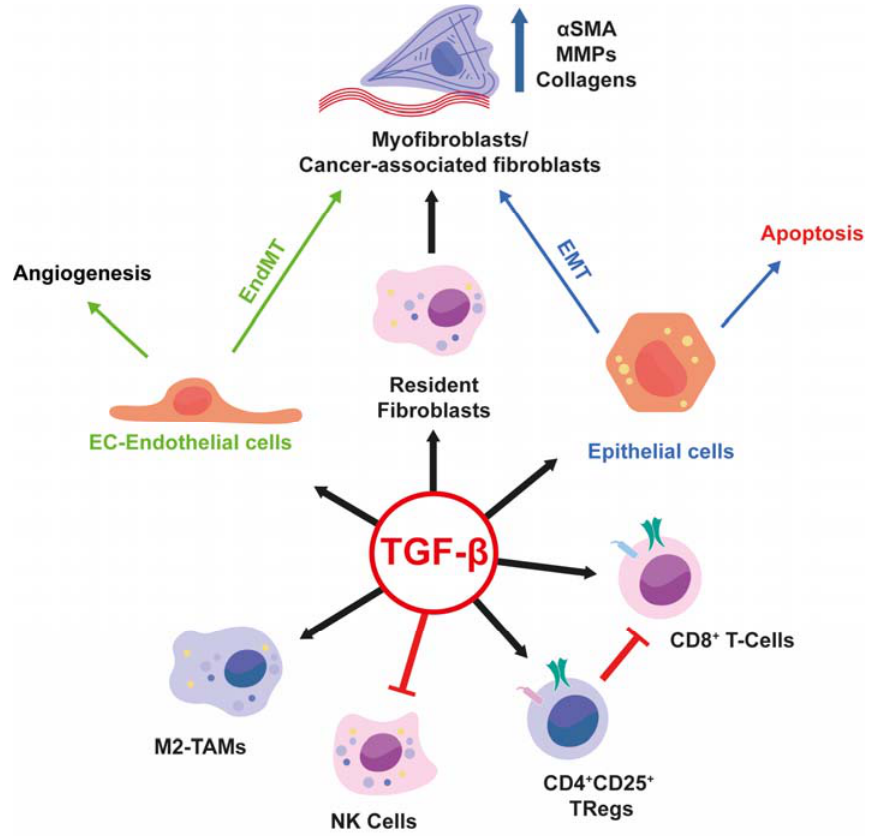
Figure 4. Graphical abstract highlighting the pleiotropic actions of TGF- β on different cell types, which explain how TGF- β influences the microenvironment, contributing to the development and progression of fibrosis and cancer. Red lines indicate inhibition of the indicated cell type activity. Black arrows indicate activation of the indicated cell type. Green arrows indicate that Endothelial cells upon TGF- β stimulation can undergo either Angiogenesis or EndMT. Blue Arrows indicate that epithelial cells after TGF- β stimulation can undergo apoptosis or EMT.